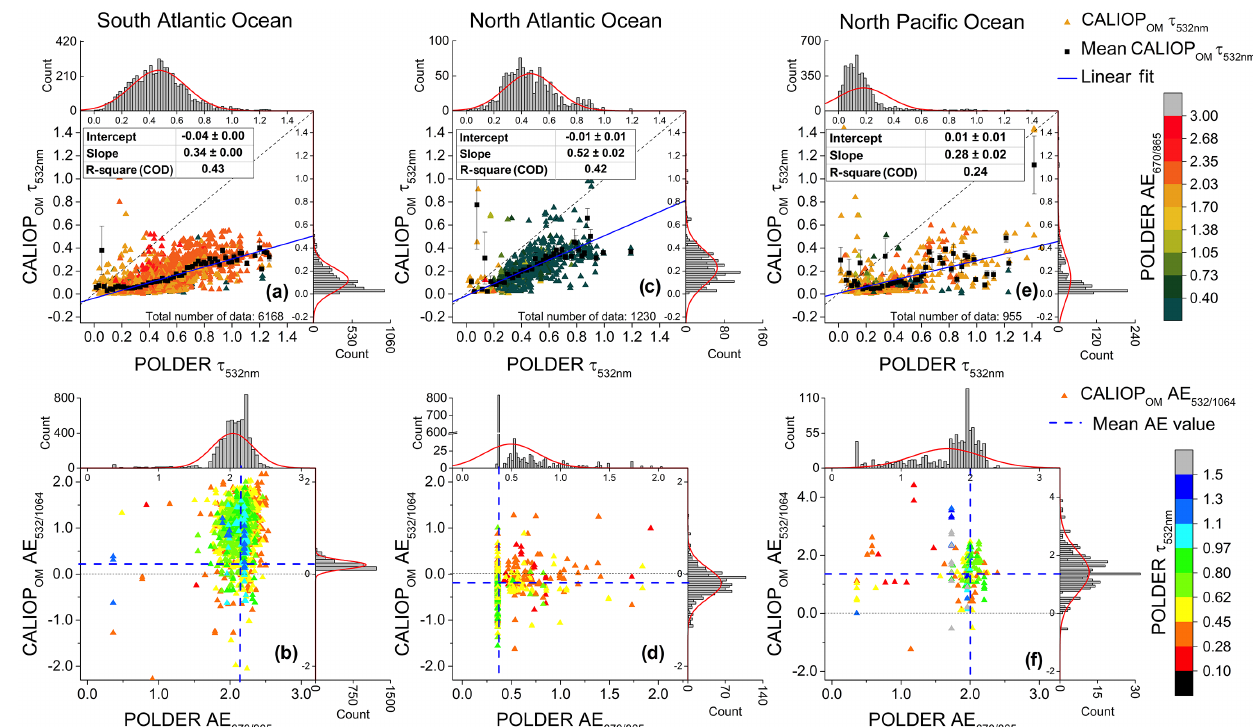
Figure 4. Same as Fig. 3, retrieved from CALIOP operational method and POLDER